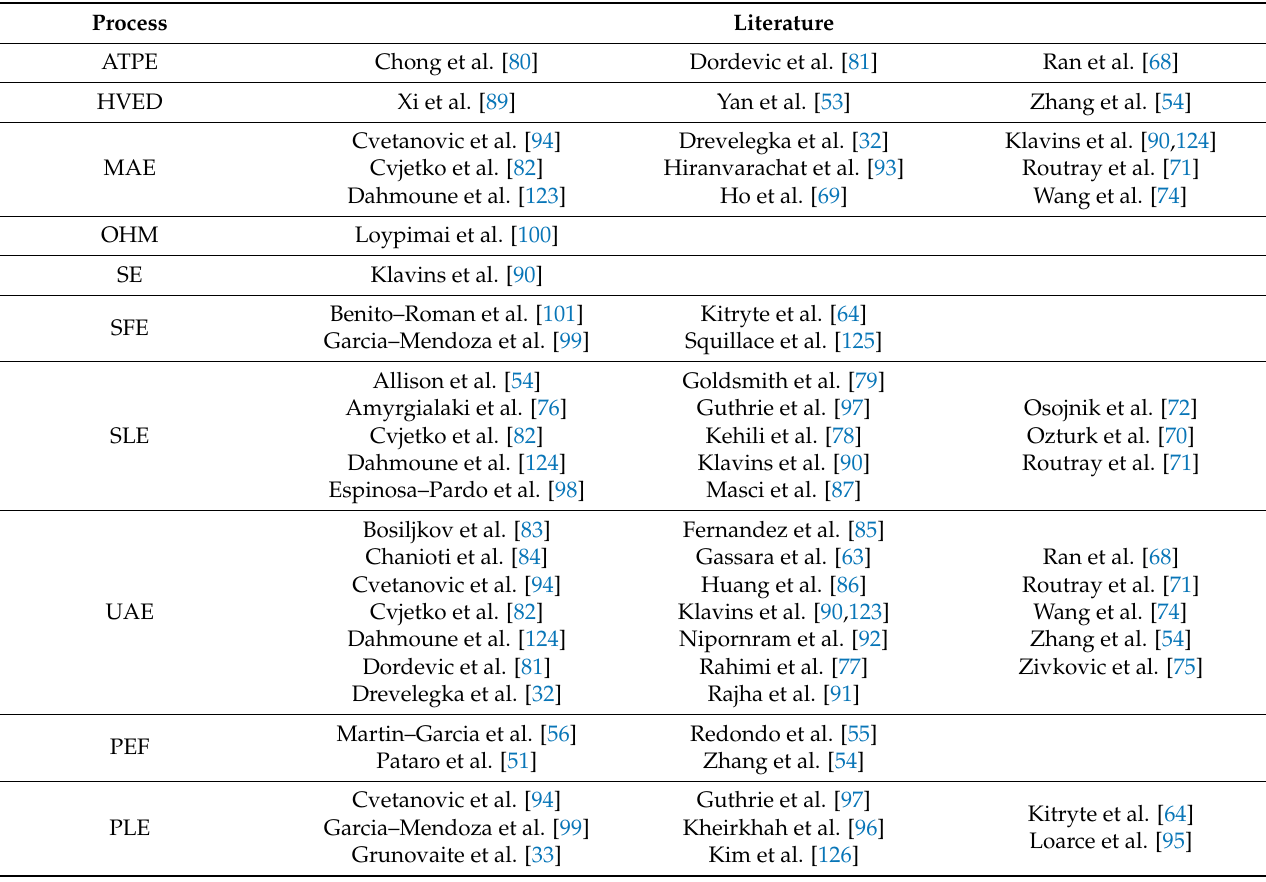
Table A1. Literature overview for investigated and developed extraction processes.